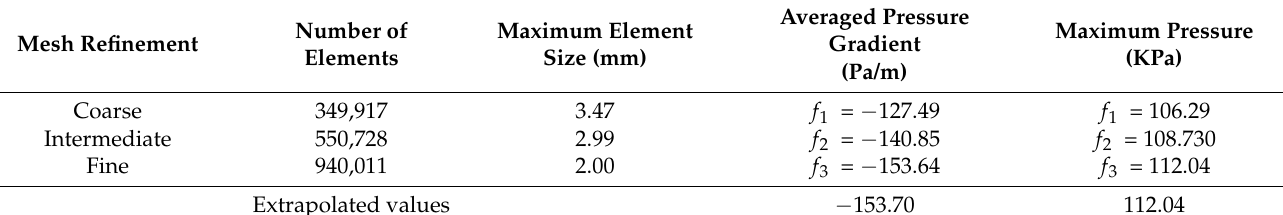
Table 4. Mesh refinement and convergence